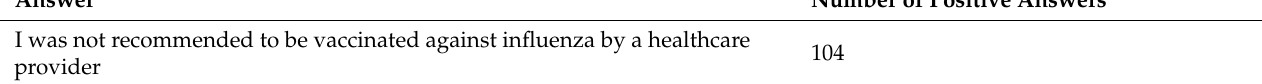
Table 3. Main reason not to be vaccinated against influenza—patients who did not receive the flu shot—178. Answer Number of Positive